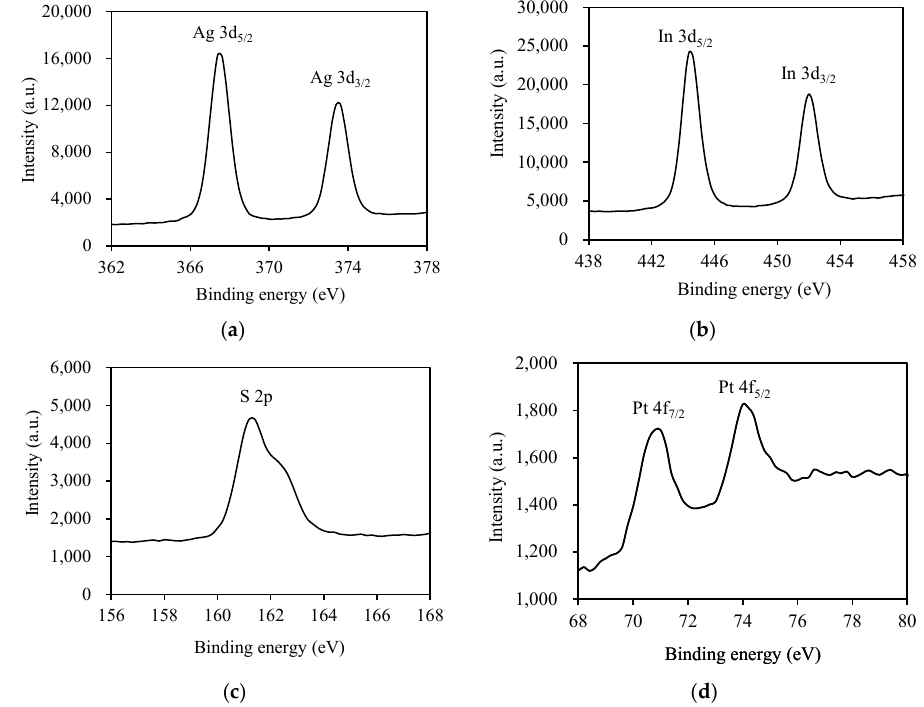
Figure 4. High resolution XPS spectra of 1.0 wt% Pt/AgInS 2 photocatalyst: ( a ) Ag 3d; ( b ) In 3d; ( c ) S 2p; ( d ) Pt 4f.